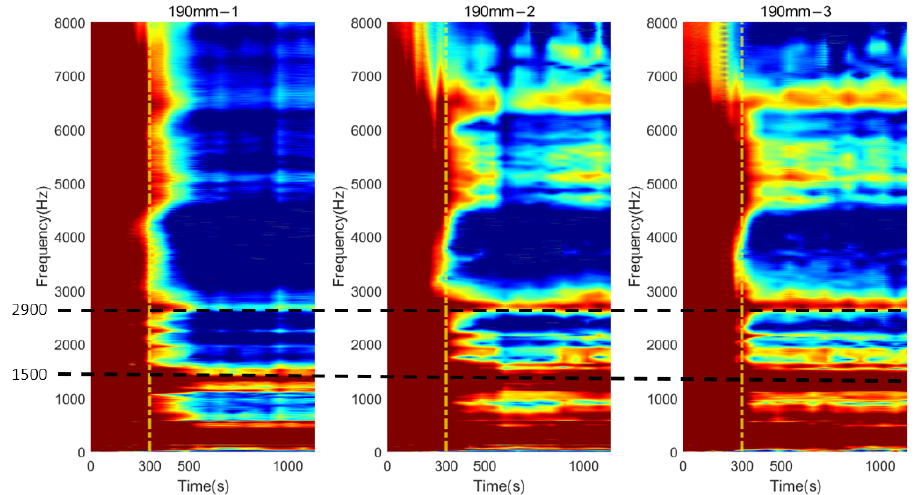
Figure 12. Colormap of the normalised magnitude development as a function of cure time for 190 mm.